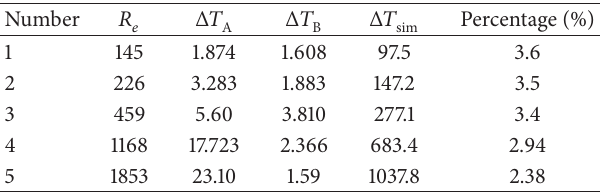
Table 2: Time difference of ultrasonic wave at points A and B.